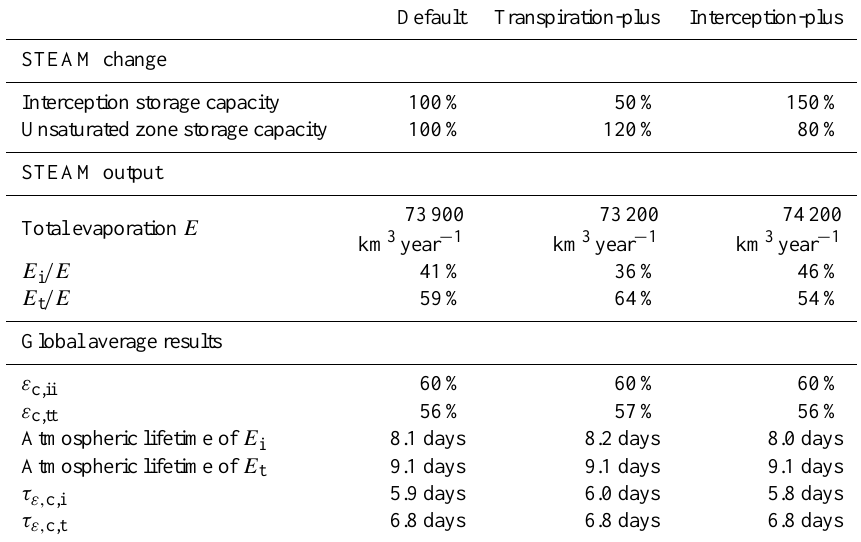
Table 2. Global differences in moisture recycling behaviour for direct evaporation (mostly interception) and transpiration for different evaporation